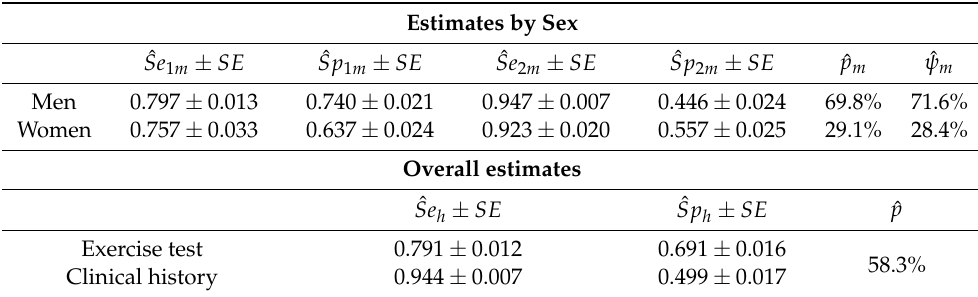
Table 7. Results obtained in the study of Weiner et